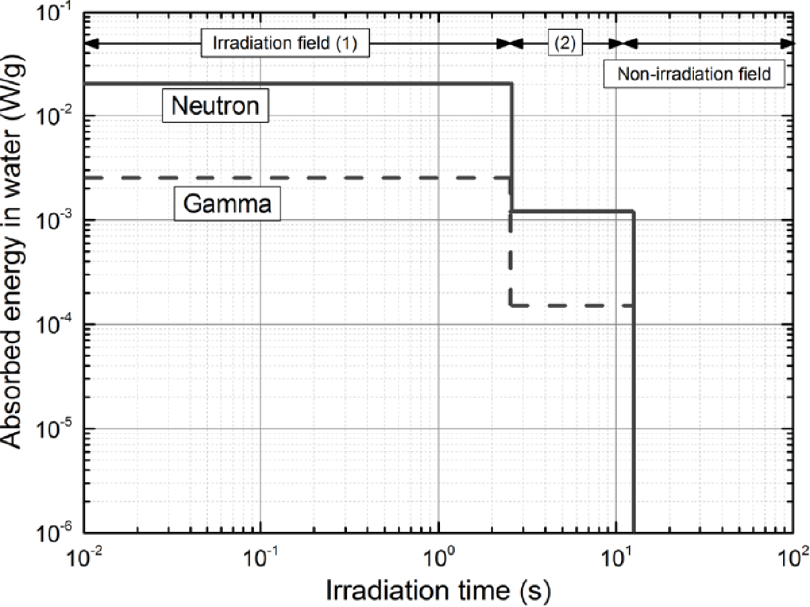
Figure 17. Energy dose rates of neutrons and gamma photons in the two radiation fields assumed in [25]. © 2006 ITER Organization. This image is hereby used courtesy of the ITER Organization. The modeled radiolysis of the coolant in the blanket PHTS of ITER as a function of the radiation zone at a temperature of 150 °C and for (added) hydrogen concentration of 2 ppm (1 × 10 −3 m) is presented in Figure 18 [25]. As expected, radiolysis occurs most in- tensively in Region 1, which is subjected to the highest energy dose rate (Figure 19). On passing into Region 2, where both the neutron and gamma dose rates are lower (Figure 18), the concentrations of the radiolysis products are lower, particularly the concentrations of OH and O 2 , but the decrease in the concentration of H 2 O 2 is quite modest. On entering the nonradiated zone, the concentrations of all radiolysis products are sharply reduced, except that of hydrogen peroxide. Note that the rate of thermal decomposition of H 2 O 2 at 150 °C is slow and accounts for the persistence of hydrogen peroxide into the nonradiated zone. These results are in line with similar work carried out on fission reactors, as dis- cussed above.